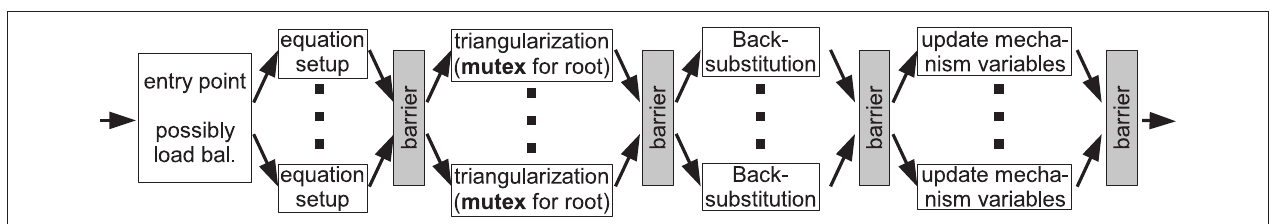
FIGURE 10 | Flowchart illustrating how a time step is performed with multiple threads. While several barriers must be used to separate confl icting parts of the program, mutexes are used during triangularization when two threads access the same root compartment of a split